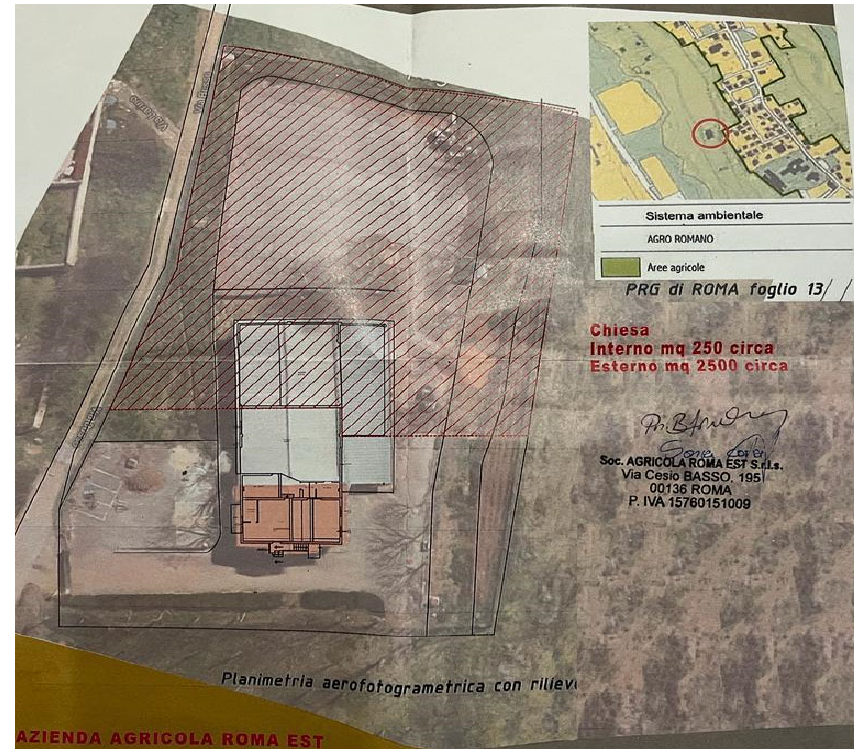
Figure 4. Plan of the